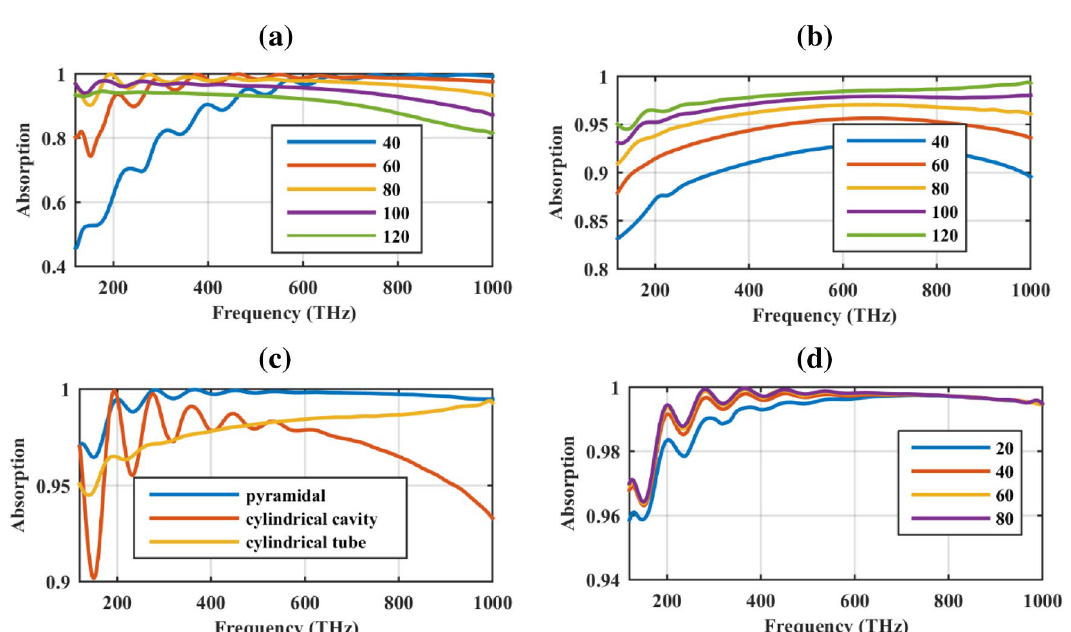
Figure 8. The absorption rate of the cylindrical ( a ) cavity and ( b ) tube for different thicknesses. ( c ) Comparison of the absorption rate of pyramidal solar cell with the optimum cylindrical cavity and tube solar cell. ( d ) The impact of the substrate thickness in the absorption rate of the pyramidal